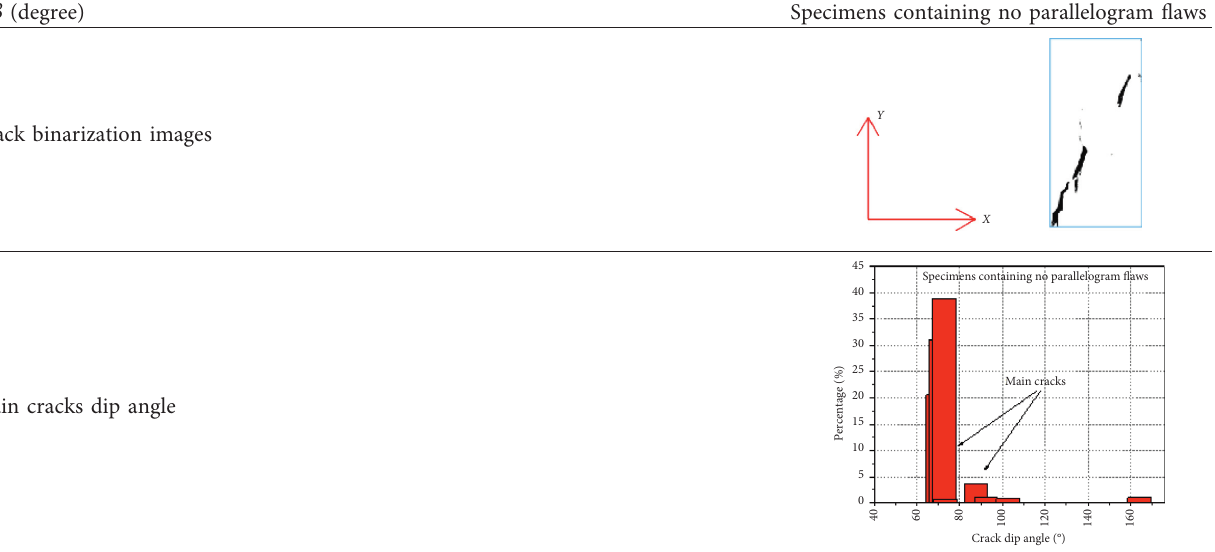
Table 8: Crack binarization images and the distribution of main cracks dip angle in ultimate failure modes of the specimens containing no parallelogram flaws under uniaxial compression.